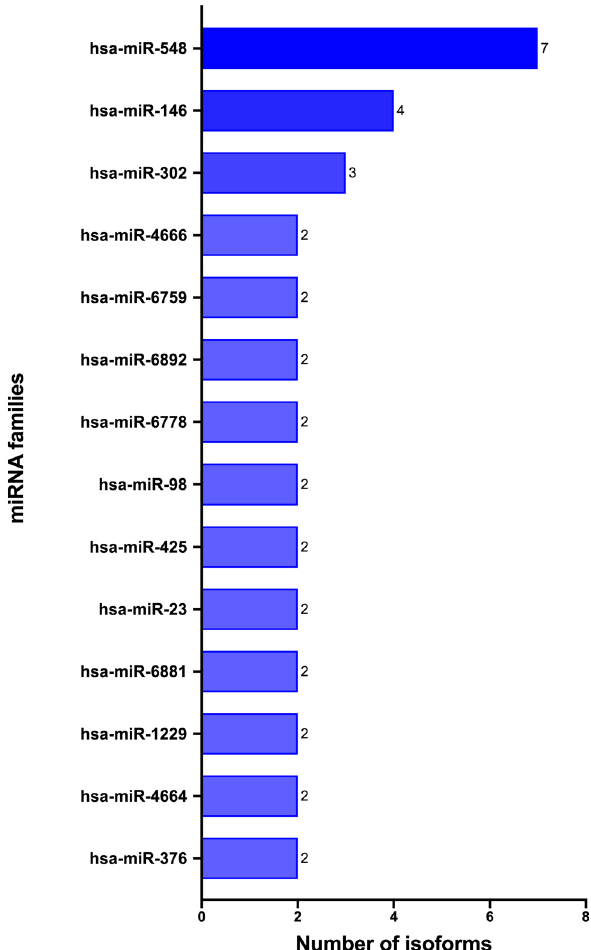
Figure 5. Abundance of isoforms for human microRNAs correlated with immunity topic in